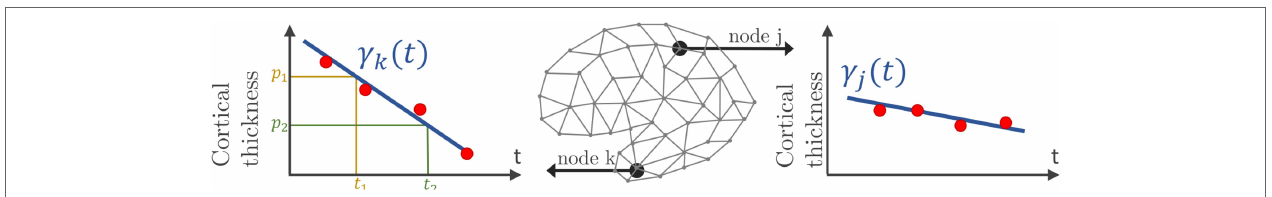
FIGURE 2 | Mesh of the cortical surface where each node embeds a time-series of observations (red points). At node k , the function γ k ( t ), which can be parametrized by a velocity and two different sets ( p 1 , t 1 ) or ( p 2 , t 2 ), estimates the cortical thickness over time.